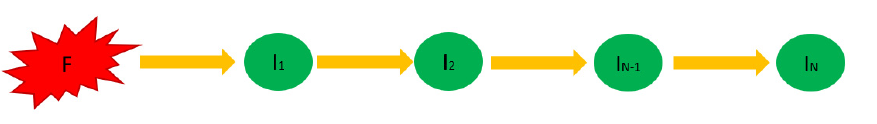
Figure 4. Cascading effect (F: Fire, Ii: Infrastructures, N: number of interdependent infrastructures).